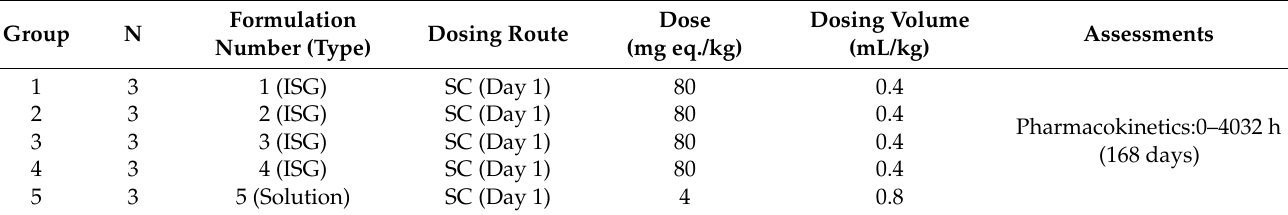
Table 2. Pharmacokinetic study design in